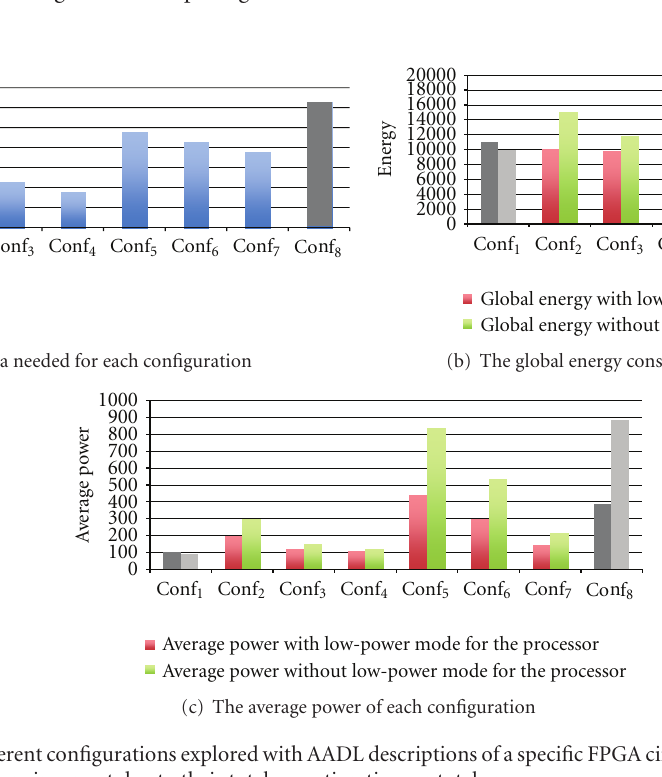
Figure 10: Results for the di ff erent configurations explored with AADL descriptions of a specific FPGA circuit and a set of tasks. As previously mentioned, Conf 1 and Conf 8 are incorrect due to their total execution time or total area.